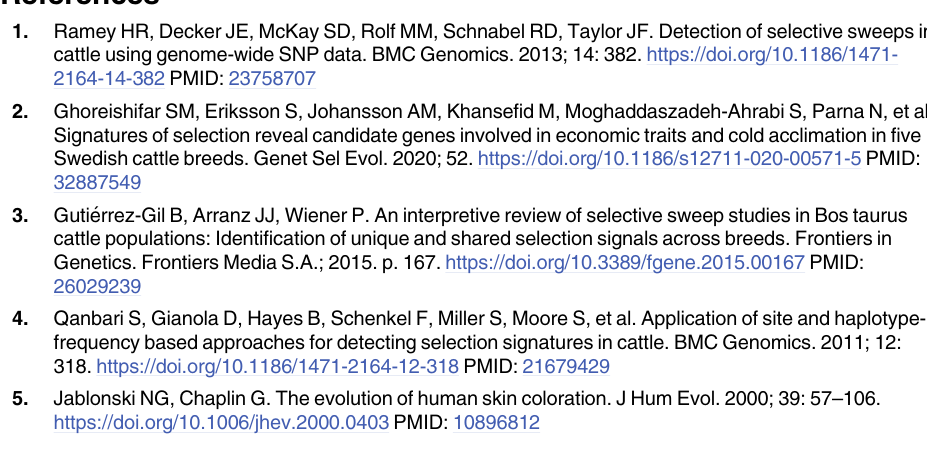
S9 Table. Genes that mapped to genome regions on BTA4 (70.2–71.3 Mb), BTA5